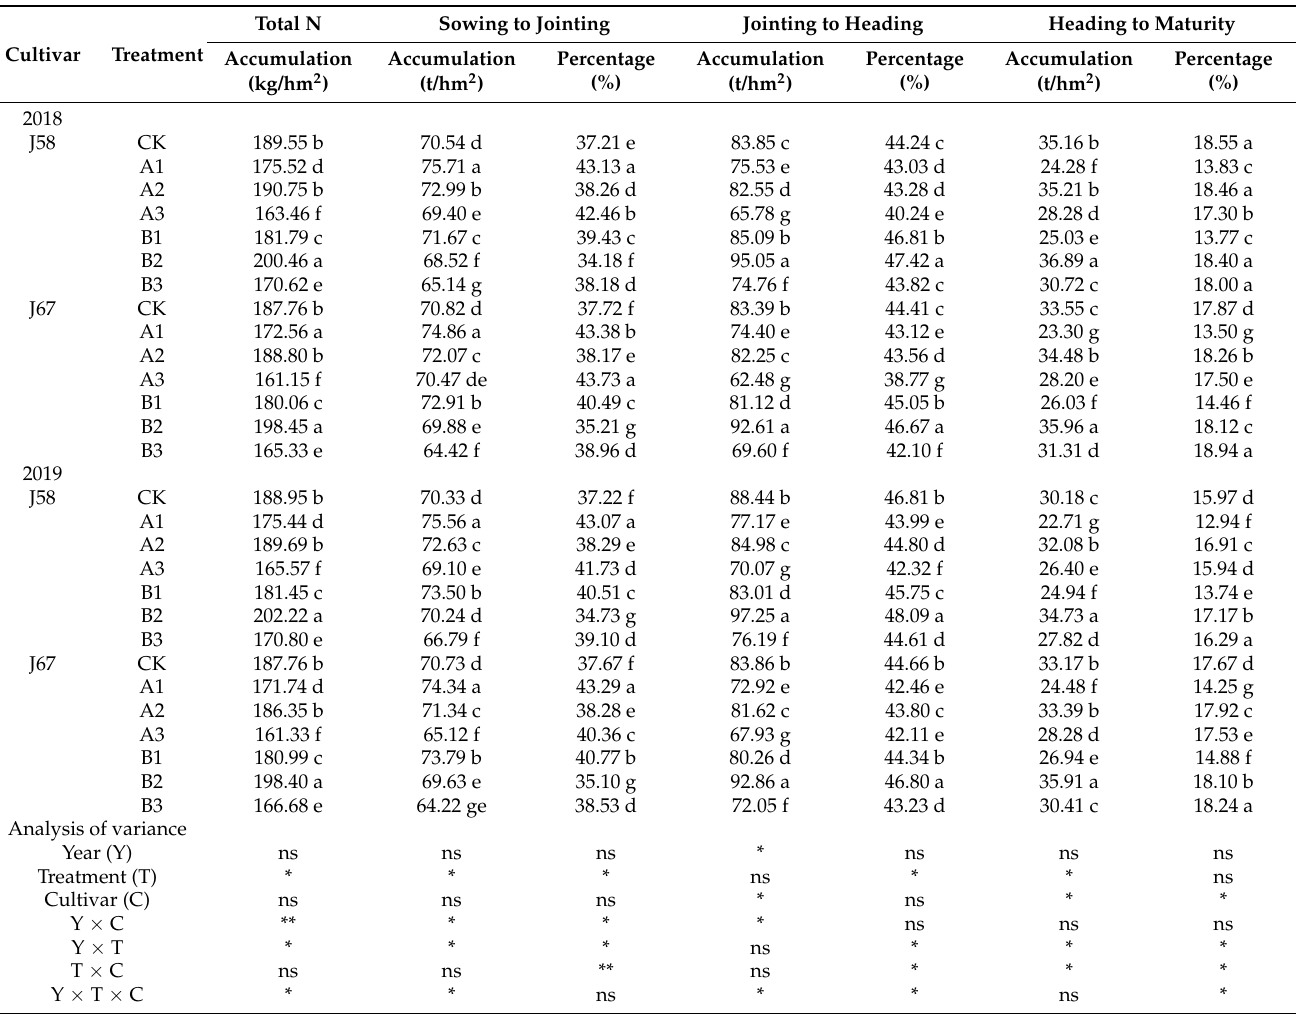
Table 6. Differences in nitrogen accumulation and its percentages in